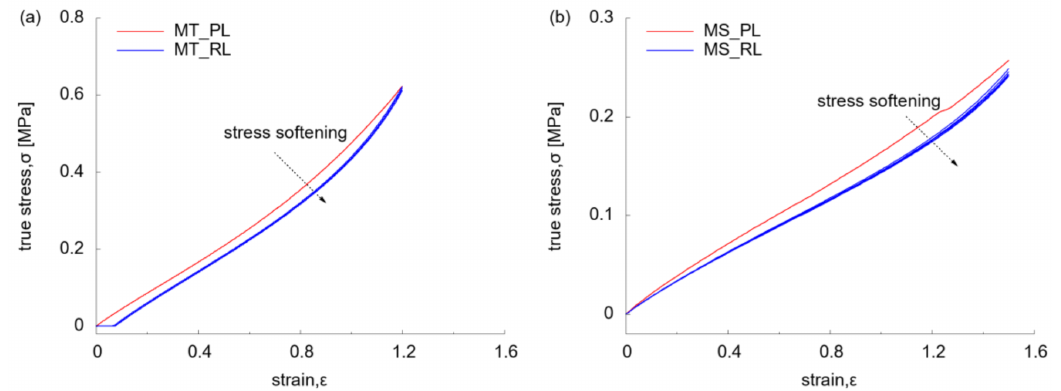
Figure 6. Stress-strain relationship under monotonic test: ( a ) at uniaxial tension (0.02 s − 1 ); ( b ) at simple shear (0.02 s − 1